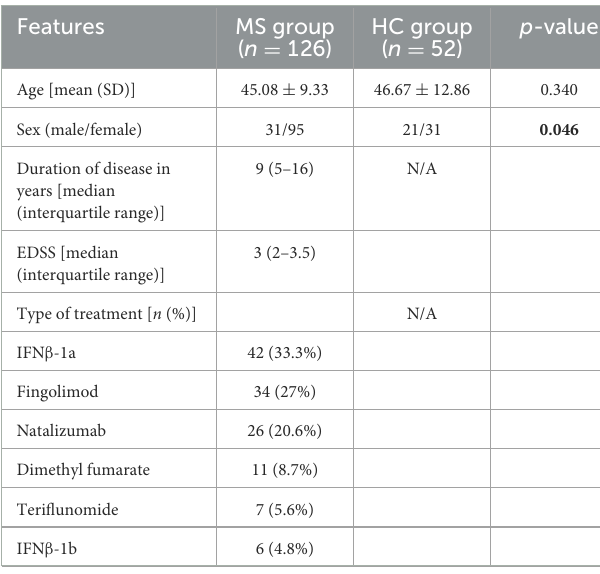
TABLE 1 Demographic and clinical characteristics of MS and healthy